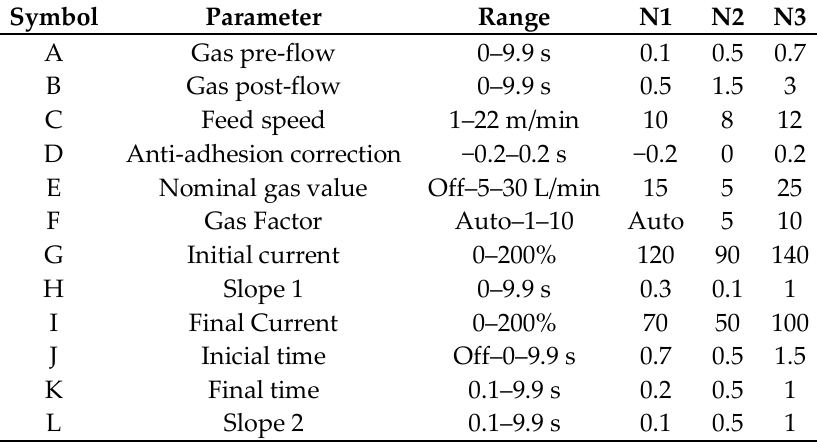
Table 2. The initial and final welding parameters and respective levels.